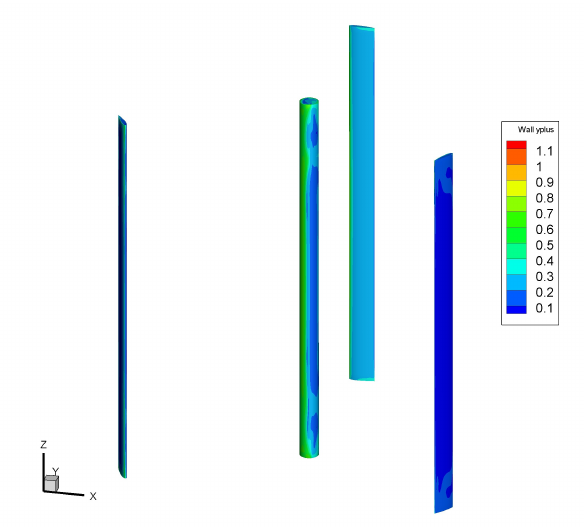
Figure 11. y + distribution near offshore wind turbine blade and spindle (TSR = 2.96).